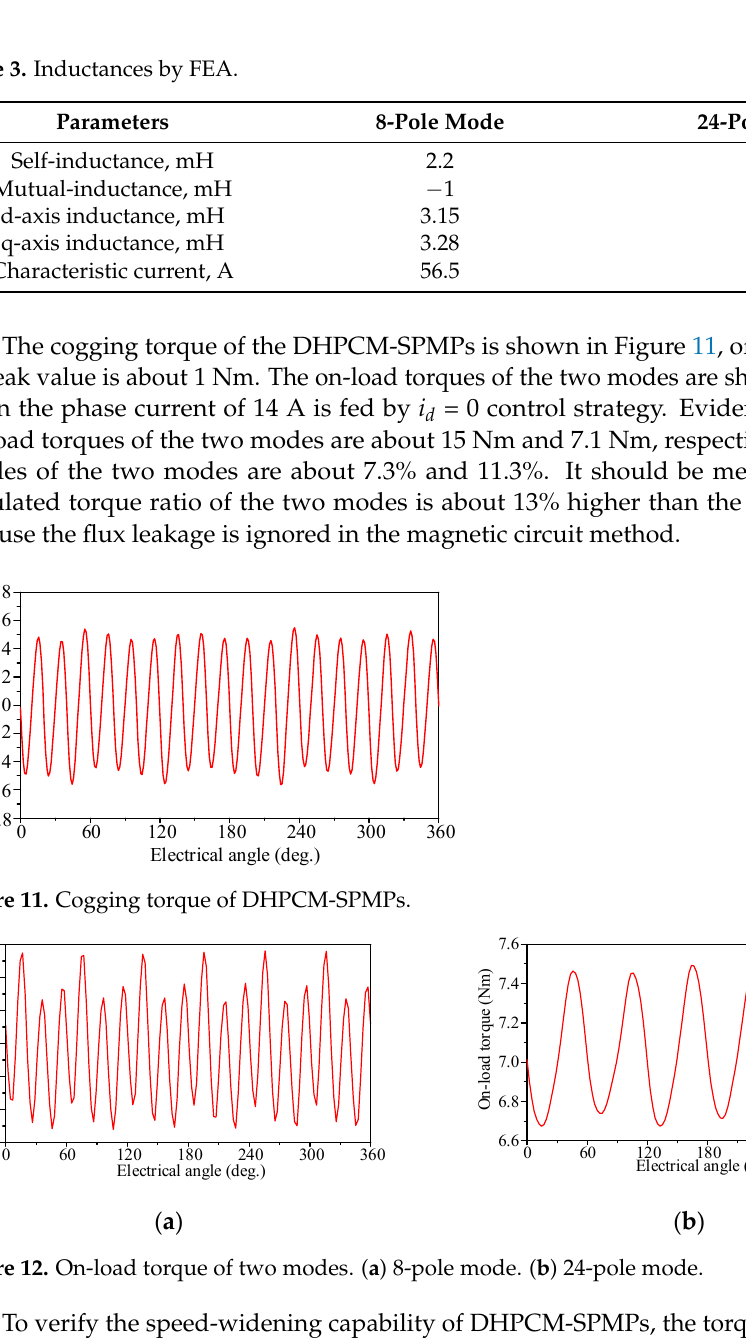
Figure 13. The torque–speed curves. The efficiency maps of the two modes are shown in Figure 14. The maximum effi- ciency of eight-pole mode reaches 97.5%, while that of 24-pole mode is 91% because of the higher iron loss caused by the higher magnetic field frequency. The high efficiency area (>80%), which is the main operation region for PM motors, shows values of 89.9% and 43.4% in eight-pole and twenty-four-pole modes, whose maximum speeds can reach 2700 rpm and 5300 rpm, respectively. The envelope curves of eight-pole and twenty-four-pole modes are consistent with those in Figure 13. To indicate the fitness of the proposed motor on the ET, the operation parameters of the motor and the ET are summarized in Table 4. It should be mentioned that the trans- mission system is simplified as a fixed-ratio gearbox with a gear ratio of 30. The diameter